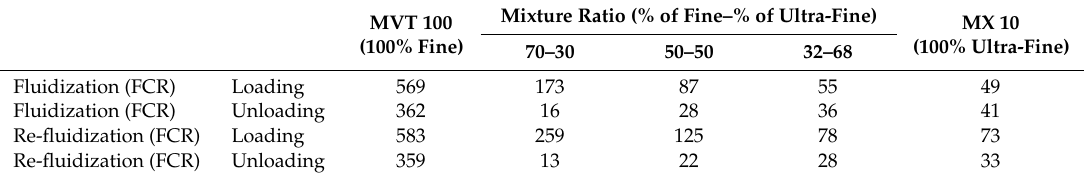
Table 9. Slopeof ∆ P b − U sg curvesforfluidizationandre-fluidizationandfordifferentmixtures(mbar · s /